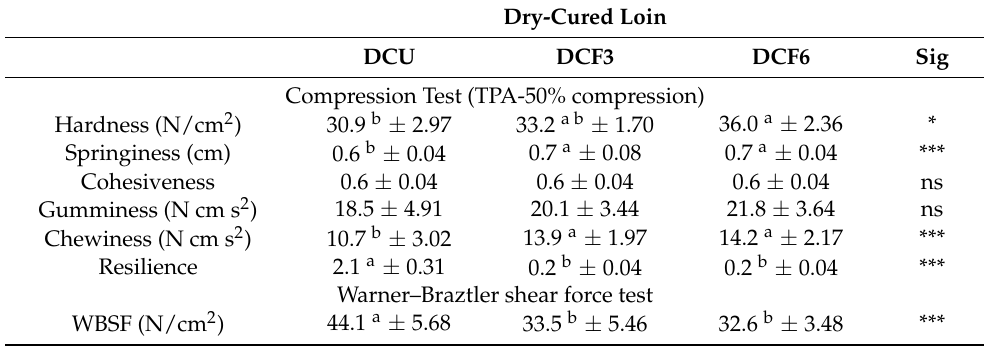
Table 4. Effect of pre-freezing cure on textural properties of dry-cured